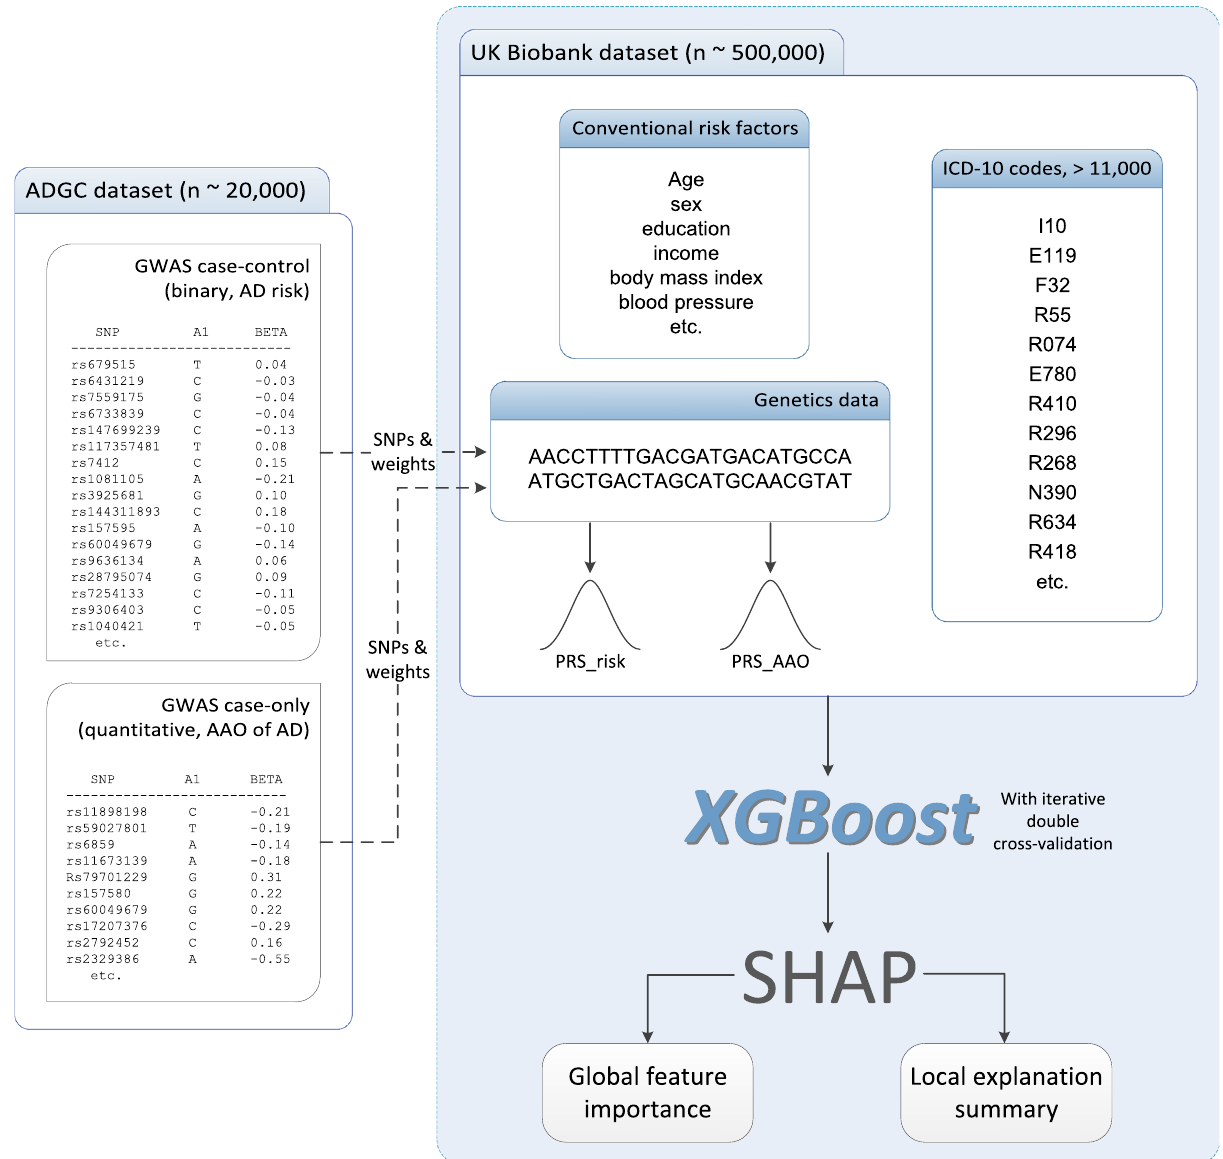
Figure 1. Flow chart of the study design. We evaluated prediction of development of Alzheimer’s disease (AD) in the UK Biobank (UKB) dataset using a large number of features/predictors, including polygenic risk scores (PRSs), conventional risk factors, and electronic health record ICD-10 codes, and state-of-the-art machine learning models. From the ADGC dataset, we conducted two GWASs, one for AD risk and the other one for age-at-onset of AD. We extracted significant genetic markers and their effect sizes (weights) from the GWAS summary statistics and applied them to the UKB dataset to derive two PRSs (PRS risk and PRS AAO ), for each individual in the UKB dataset. We then used the XGBoost (with iterative double cross-validation) and SHAP methods to build explainable machine learning models for the risk of developing AD and explored feature importance in the UKB dataset using the PRSs, conventional risk factors, and ICD-10 codes. AAO age at onset, AD Alzheimer’s disease, ADGC Alzheimer’s Disease Genetics Consortium, GWAS genome-wide association study, PRS polygenic risk score, ICD-10 International Classification of Diseases Tenth Revision, SHAP SHapley Additive exPlanations, SNP single nucleotide patterns are also seen for age, mother with AD, falls in the last year, lack of education (none of college/university or professional qualifications, detailed categories are shown in Supplementary Table 2), TDI, and comorbidities from EHR, such as diabetes, syncope and collapse, chest pain, disorientation, hypercholesterolaemia. The long right tails of several ICD-10 codes, such as N390 UTI, R410 disorientation, and R296 tendency to fall, indicate rare risk factors with large effect sizes. We also observed that PRS AAO , income, and BMI showed negative relation- ship with AD. For blood pressure, high SBP and low DBP show increased odds for developing AD.